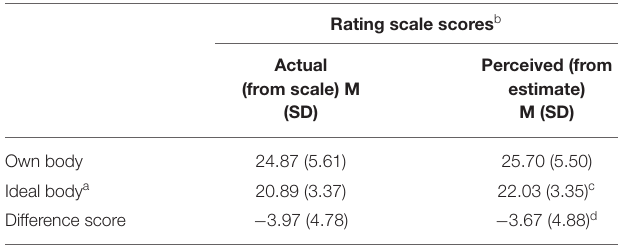
TABLE 3 | Mean figure rating scale scores for own and ideal bodies, from the actual BMI of the selections on the scale and the perceived BMI of the selections.